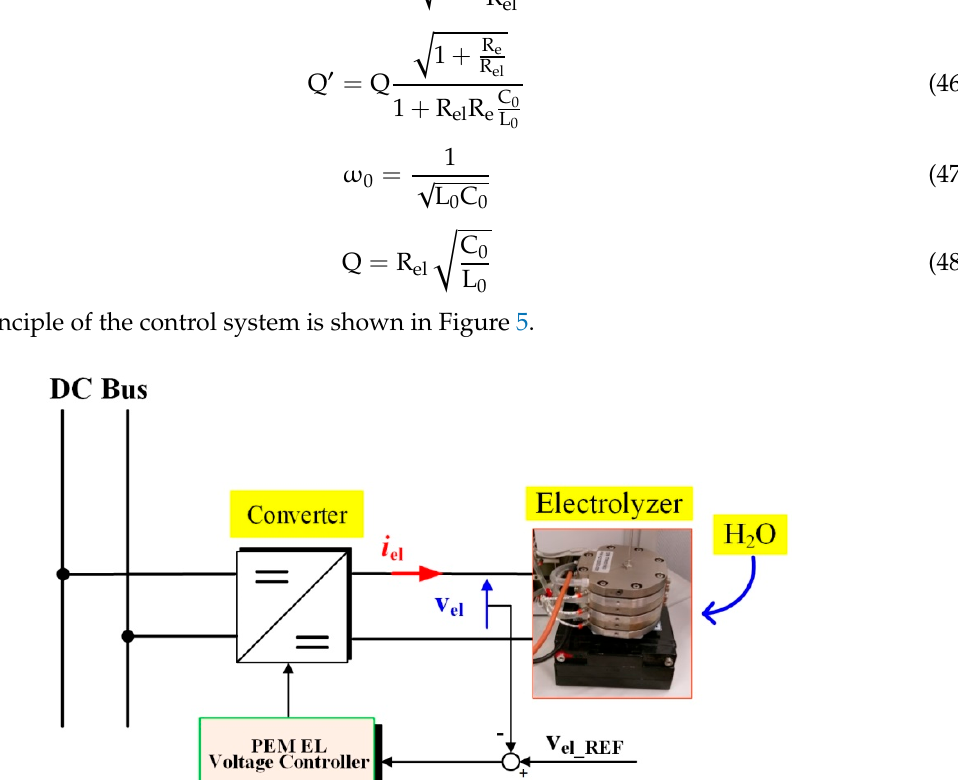
Figure 6. diagram of the uncompensated system according to the input DC voltage V dc.